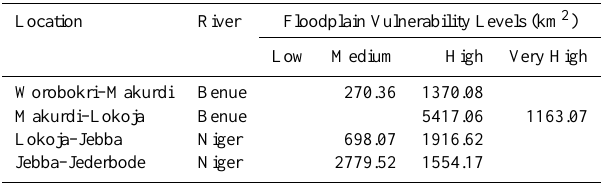
Table 3. Land use along the Niger–Benue Floodplain. Table 4. Vulnerability Index of the Lower Niger–Benue